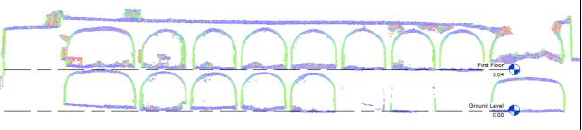
Figure 10. Vertical section of the west chambers